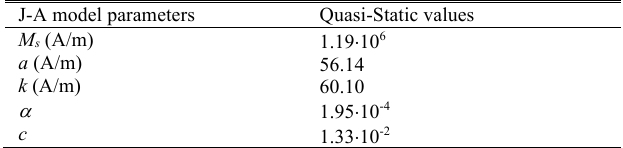
TABLE I. Major Hysteresis Loop Parameters